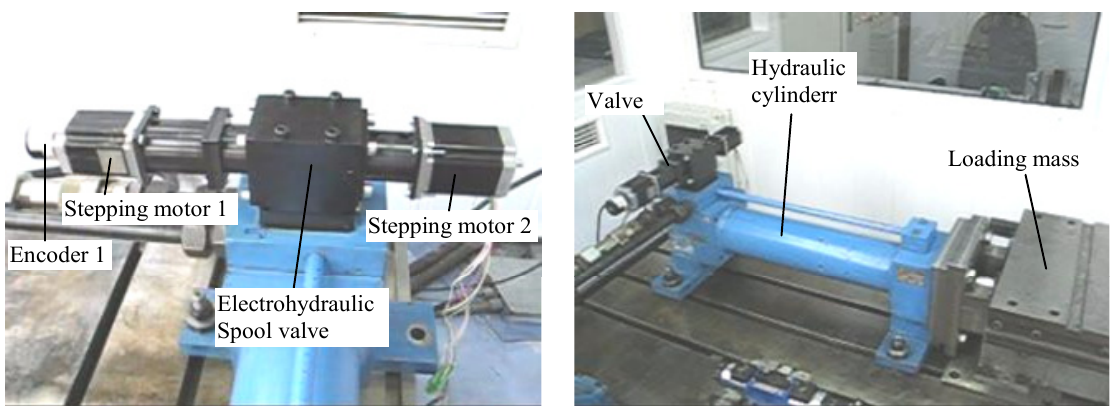
Figure 5. The photos of the valve and the electrohydraulic drive on the test stand.